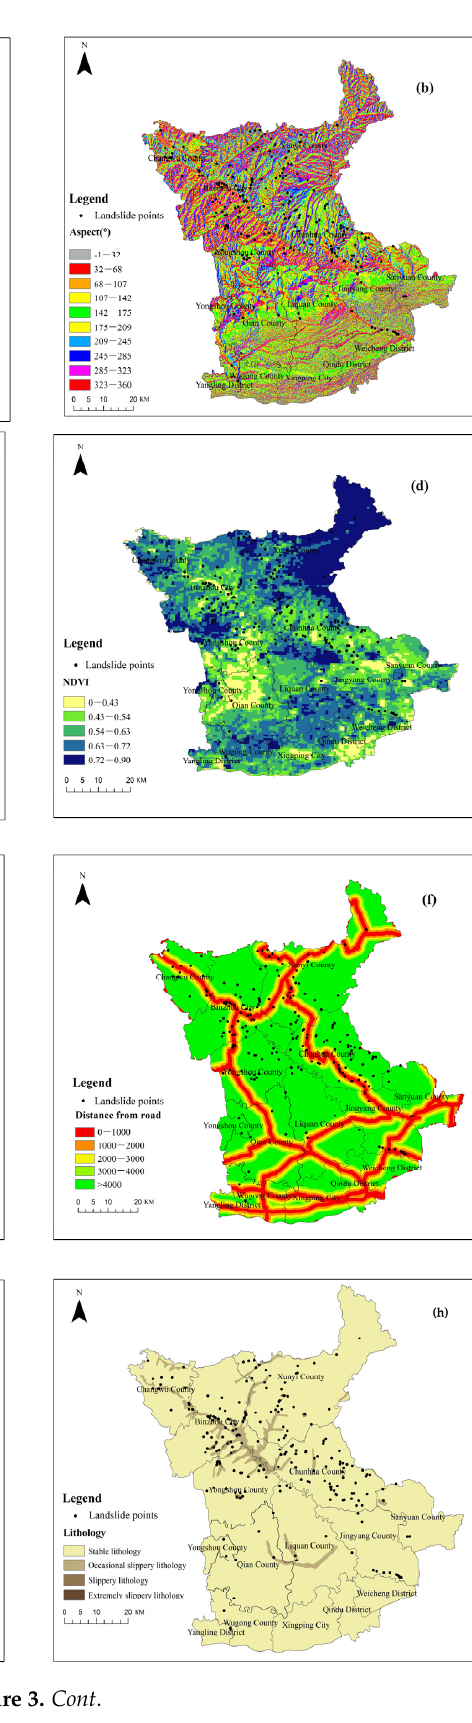
Figure 2. The landslide hazard evaluation index system.